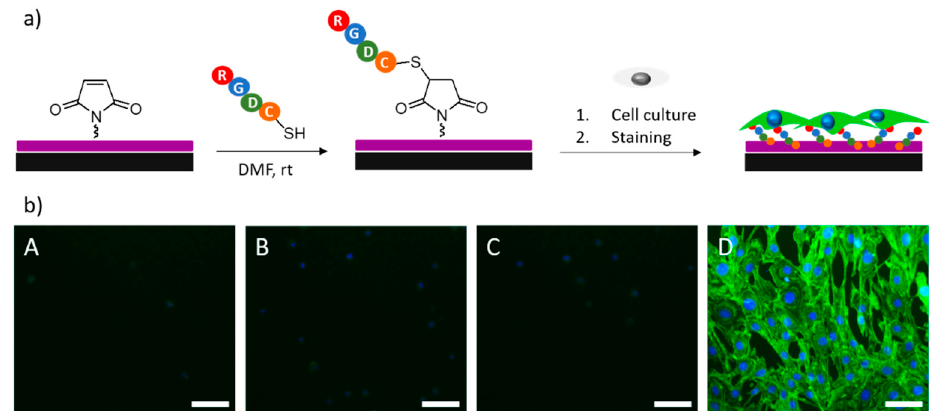
Figure 7. ( a ) Scheme of conjugation of cell-adhesive peptide RGDC and subsequent cell adhesion. ( b ) Fluorescence microscopy images of scaffolds showing Alexa Fluor 488 phalloidin (green) and DAPI (blue) staining of NIH / 3T3 mouse fibroblasts after 24 h on A) hydrogel without FuMaMA; B) FuMaMA containing hydrogel; C) maleimide-containing hydrogel and D) RGDC-functionalized hydrogel (scale bar: 50 µ m).